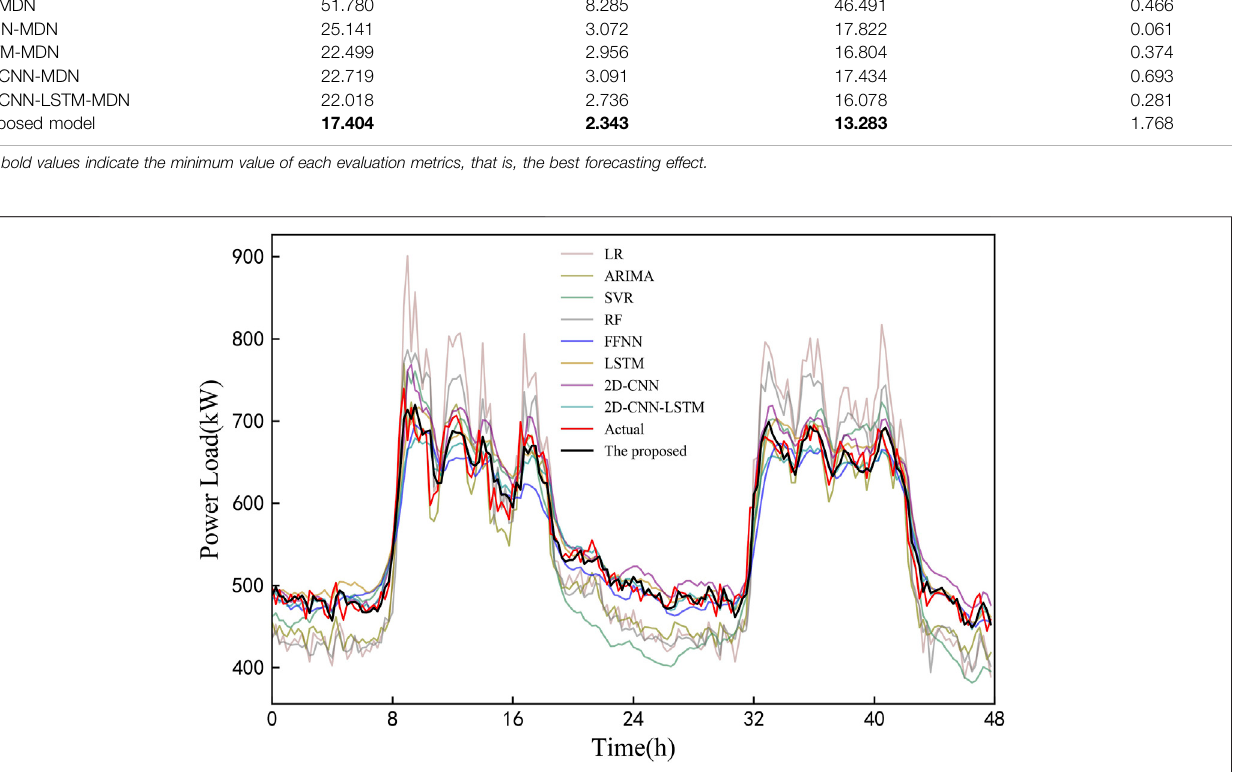
FIGURE 11 | Load forecasting pro fi les of all models in experiment 2.